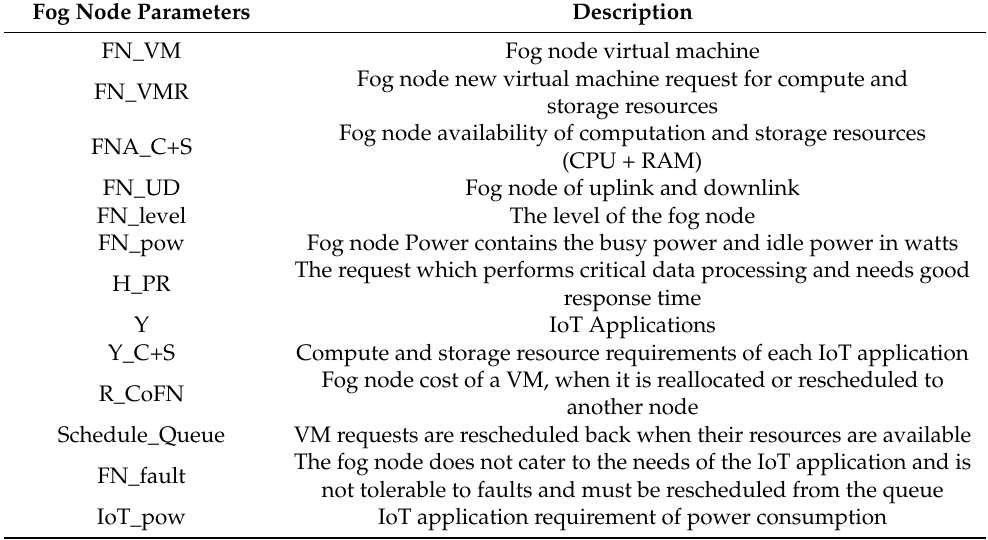
Table 1. Notations of Resources in Fog and